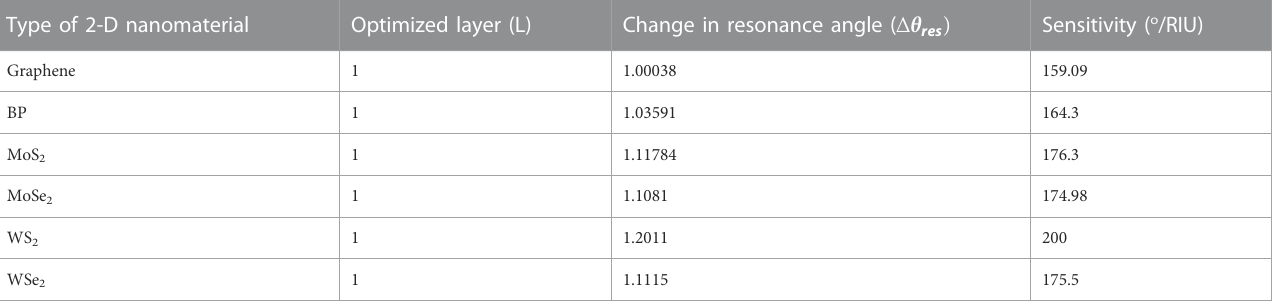
TABLE 6 Optimized layer, change in resonance angle, and calculated Sensitivity for the Structure-I, Ag/Si with 2-D nanomaterials (Graphene/BP/MoS 2 /MoSe 2 /WS 2 / WSe 2 ).